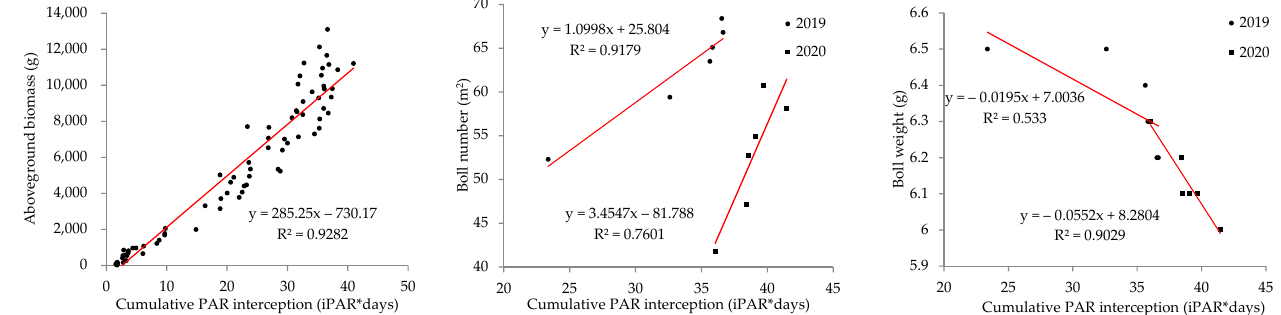
Cumulative PAR interception (iPAR*days)